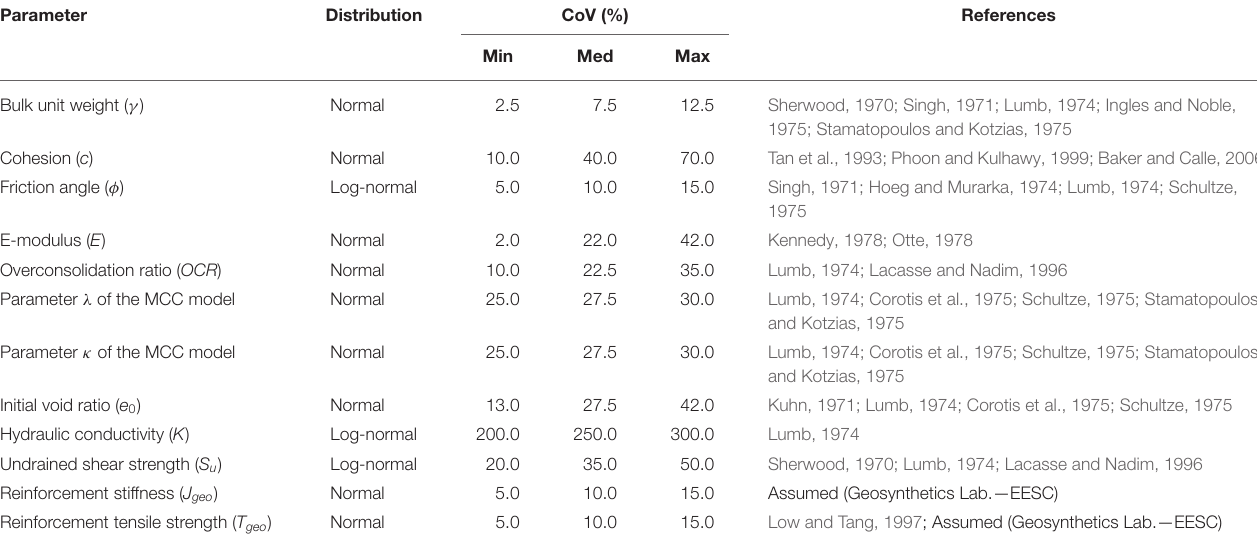
TABLE 4 | Distribution and CoV of parameters assumed as random